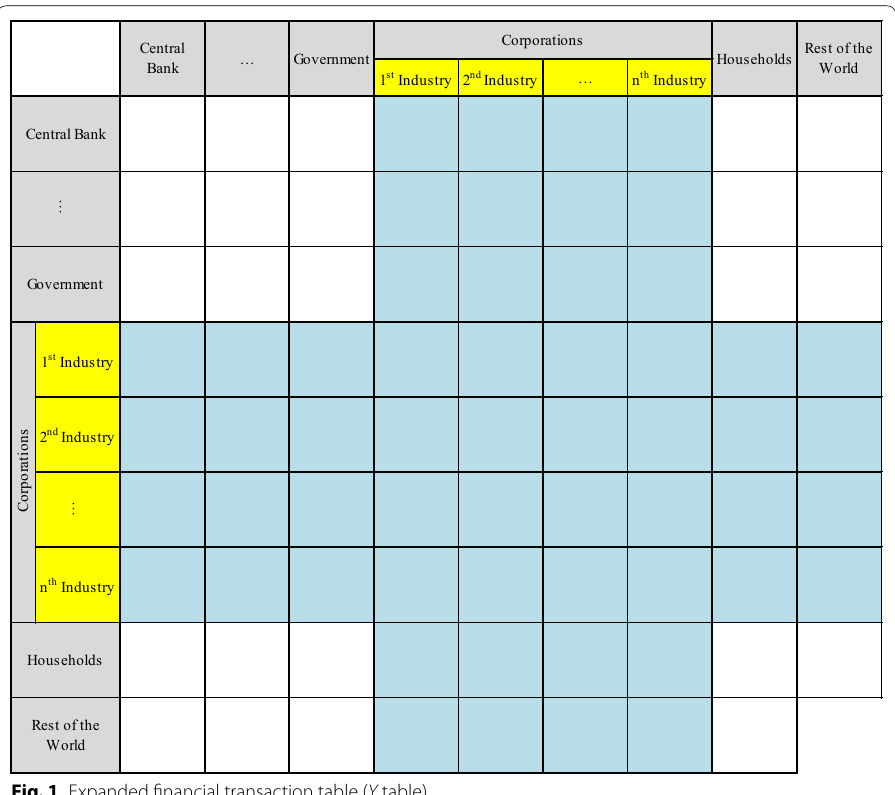
Fig. 1 Expanded financial transaction table ( Y